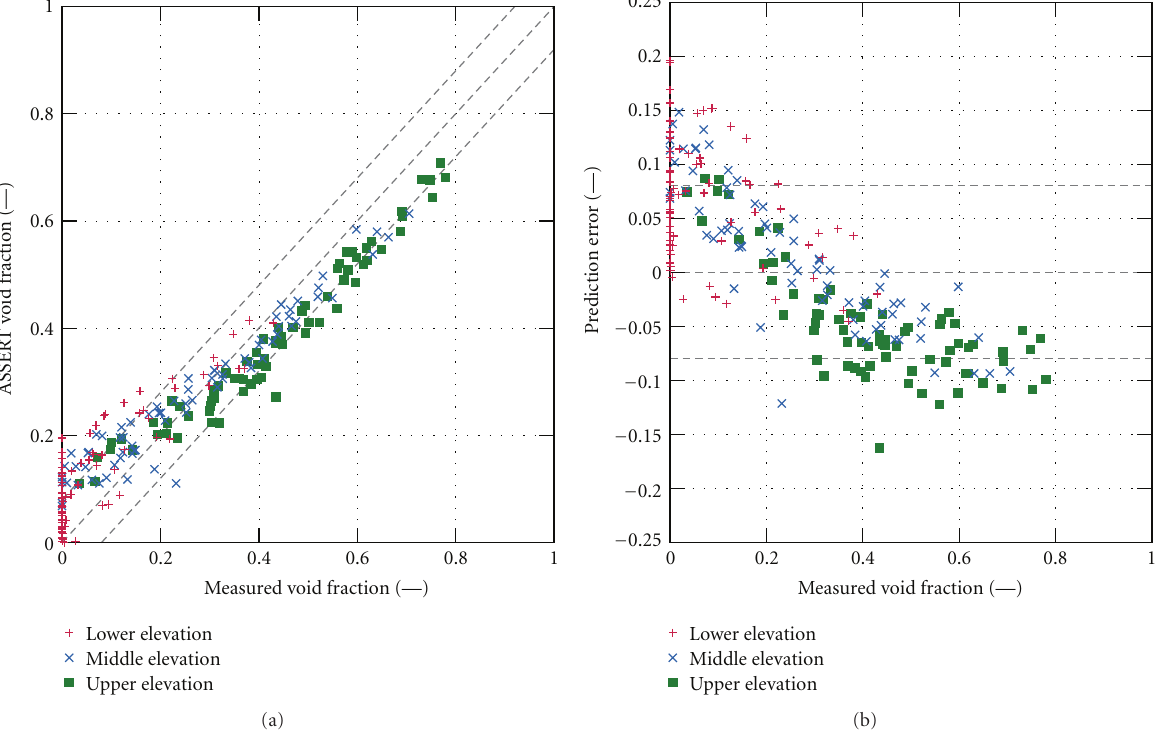
Figure 9: Steady state void fraction results for bundle test series B6. Error bands displayed correspond to 2 σ exp = 0 .